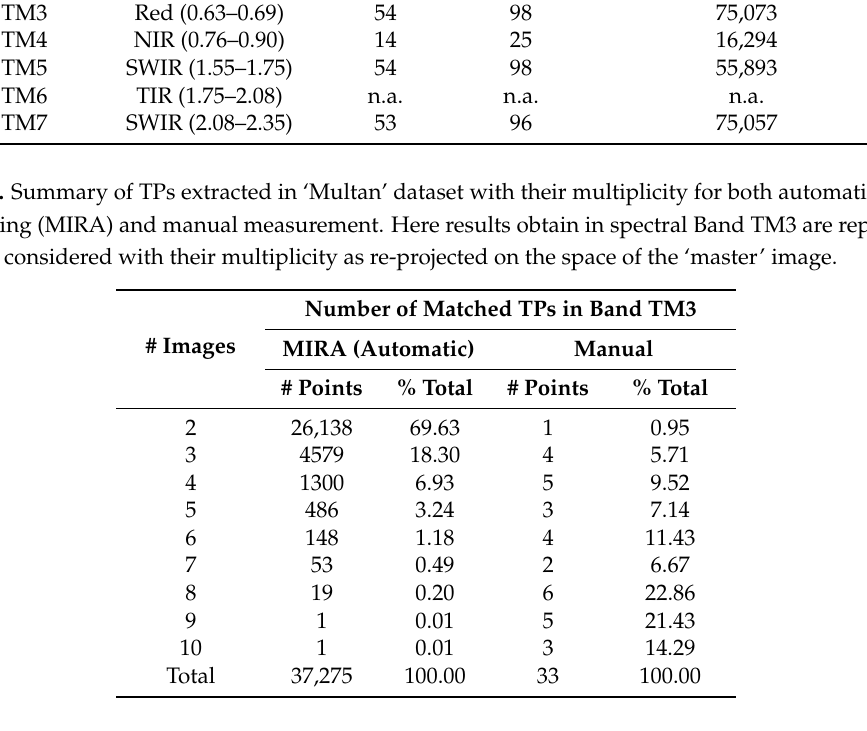
Table 3. Summary of FBM results with images in different spectral bands of ‘Multan’ dataset. The number of image pairs that have been successfully matched refers to those image pairs sharing a sufficient number (N min = 12) of corresponding features after FBM. The percentage represents the number of image pairs that have been successfully matched over the total number of potential image combinations (n.a.: not applicable). Image Pairs Band (nm)